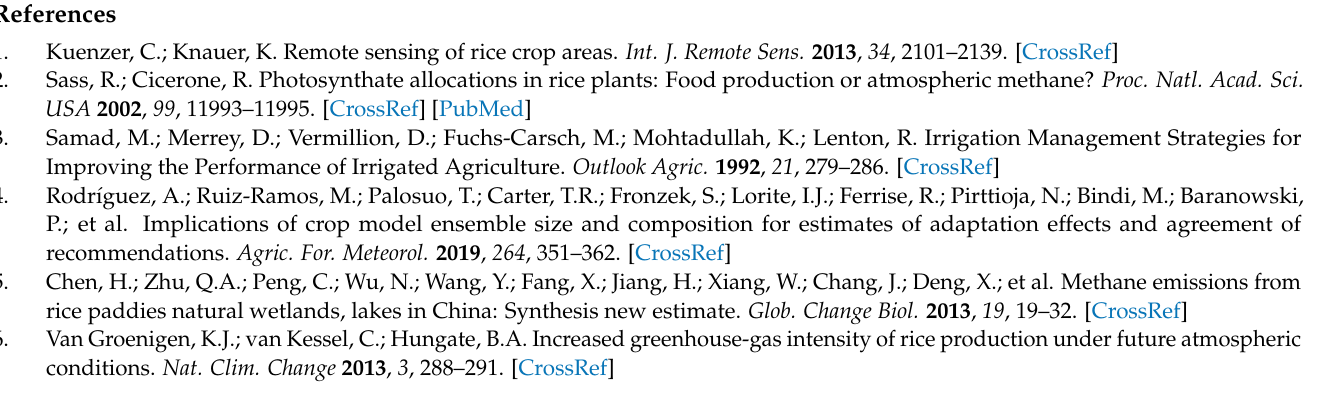
Figure S2: The statistics of the start and end of flooding signal of the samples around three sites